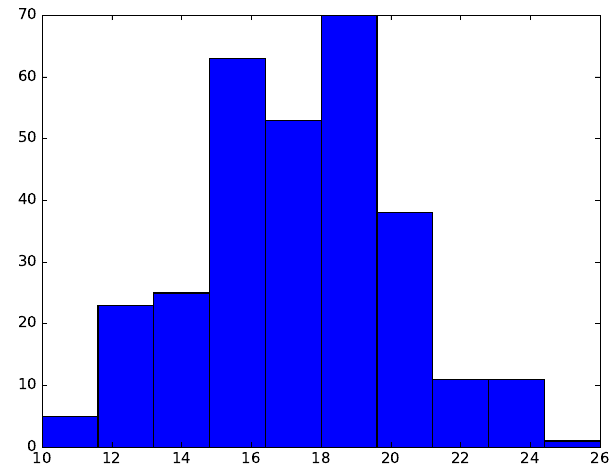
Figure 11 . Histogram of the number of bound states formed in 300 simulations with the same initial conditions as in (cid:12)gure